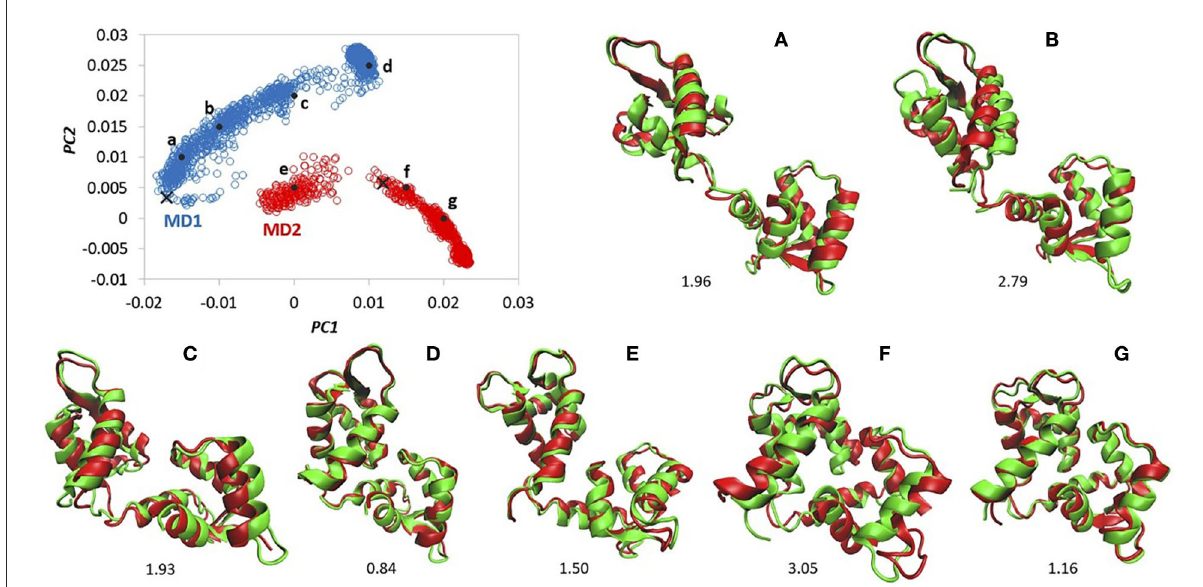
FIGURE3 Textile predictions of CaM. Top left: PC2 vs PC1 plot from the 2D RMSD matrix constructed from two MDS (blue and red circles), with points a–g (black dots) used for testing. The black crosses belong to the starting textiles for each simulation. For each textile, testing only included the MD simulation that the textile was not taken from (MD2 for a–d, MD1 for e–g). Overlays of the original textile (green) with the predicted textile (red) are shown for each point (A–G) , with the RMSD shown below.